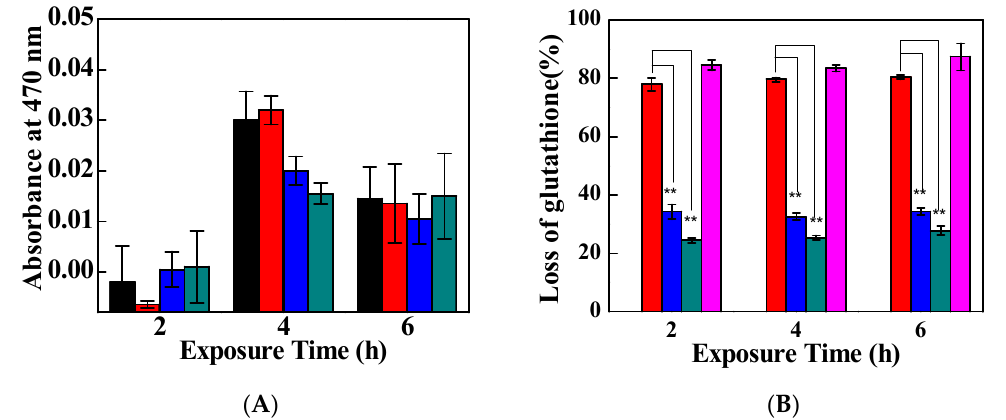
Figure 8. Oxidative stress mediated by the TC/PG nanocomposites. ( A ): reactive oxygen species (ROS)-dependent oxidative stress at exposure times of 2–6 h monitored using XTT tests. ( B ): Loss of glutathione after incubation with TC/PG nanocomposites for 2–6 h. Black columns represent the negative control, red columns represent GO nanosheets, blue columns represent PG nanosheets, and dark cyan columns represent TC/PG nanocomposites. H 2 O 2 (the magenta column) was used as a positive control.